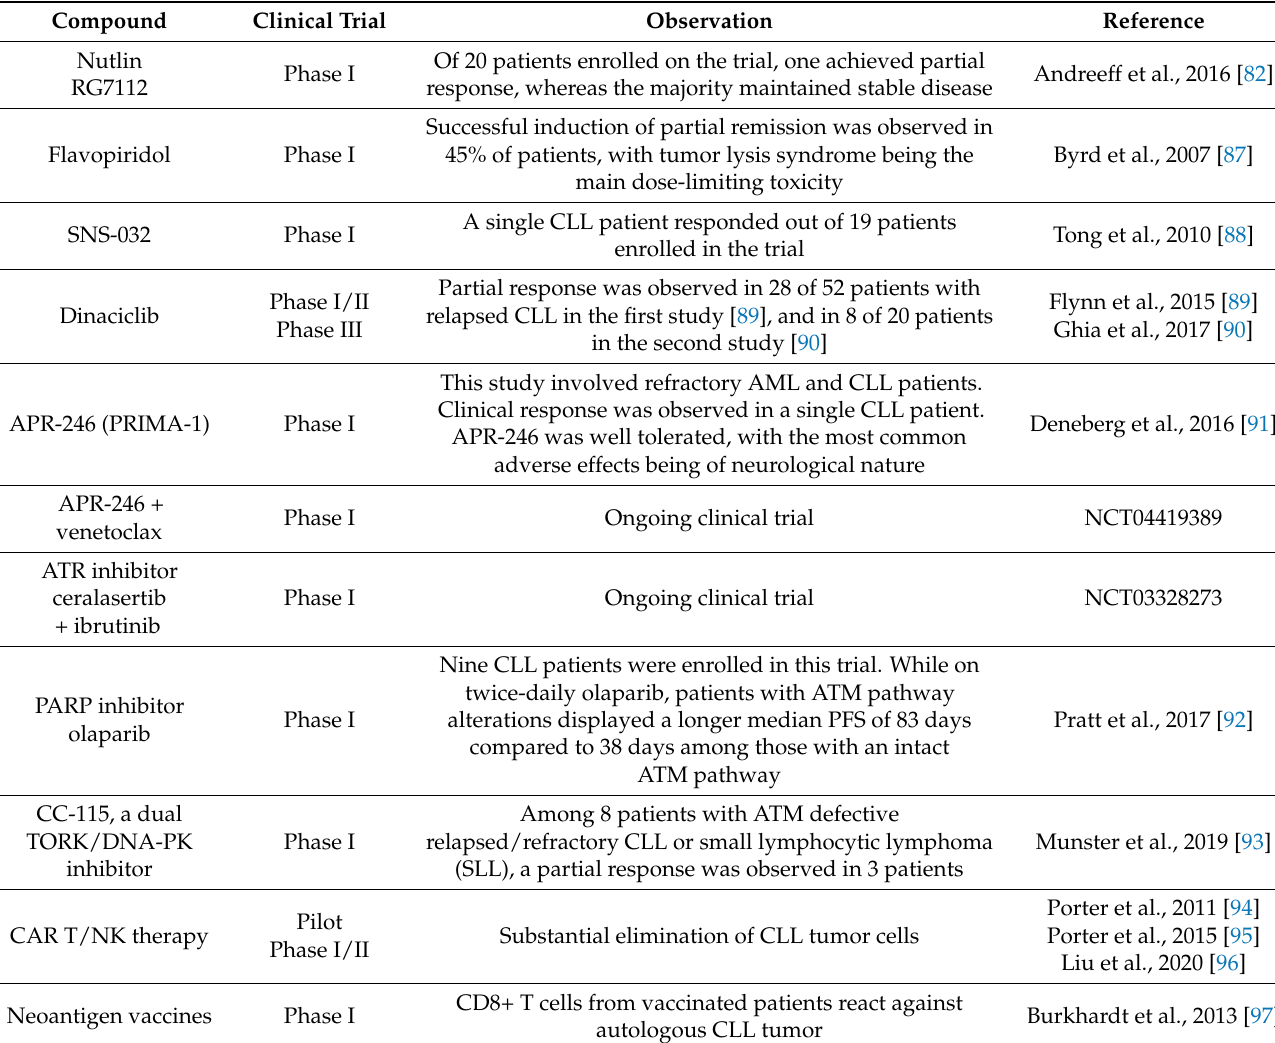
Table 3. Clinical utility of new therapeutic strategies to target defective p53 pathway in